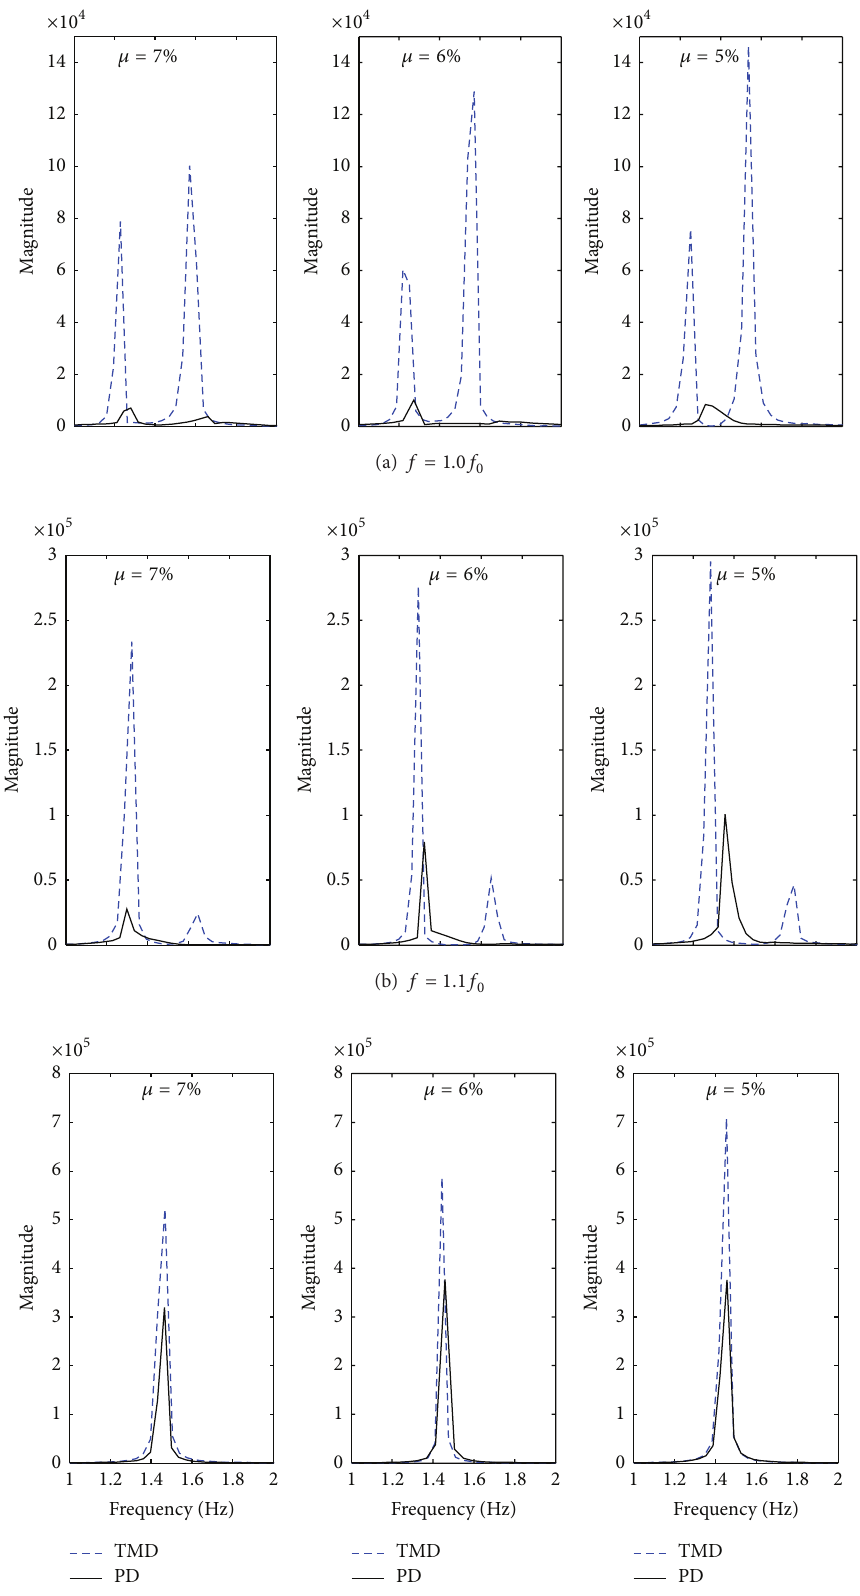
Figure 3: Frequency response of the acceleration time history of the primary